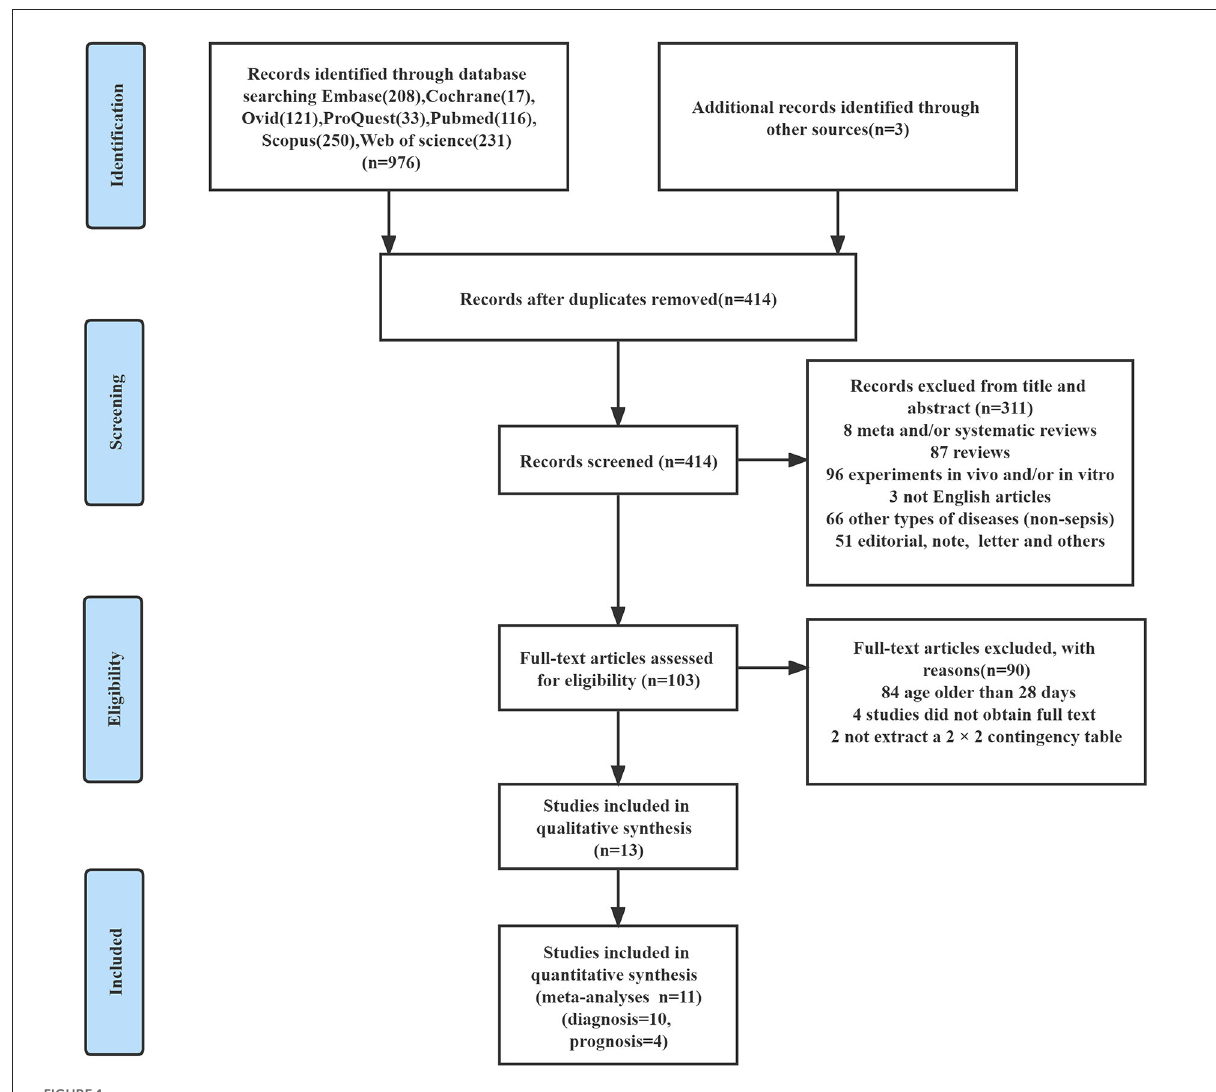
FIGURE1 The detailed flow chart for study